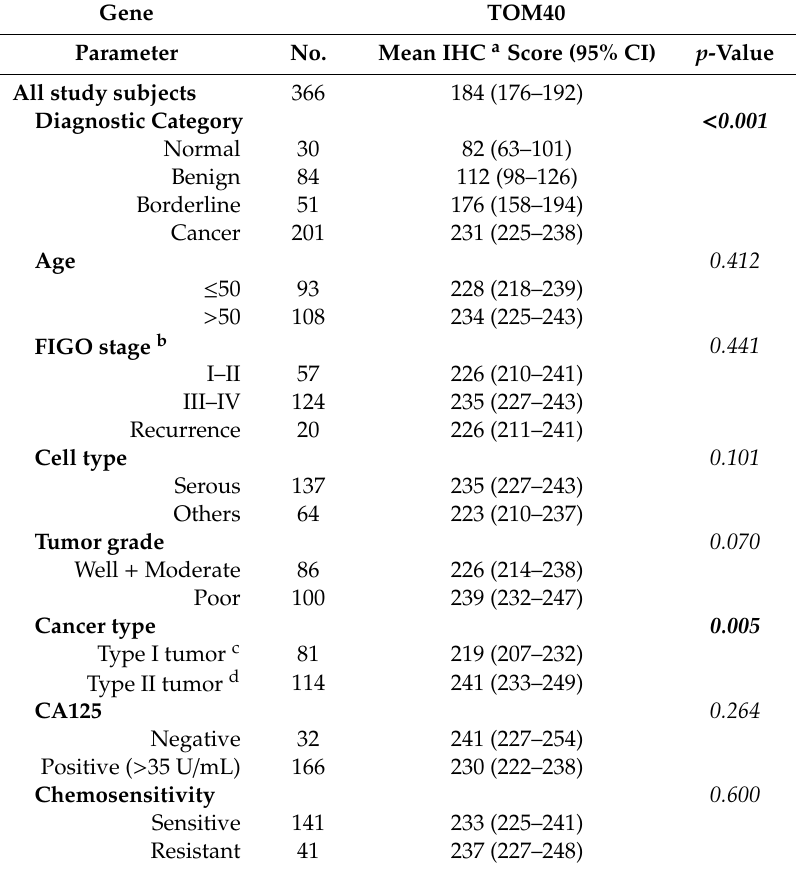
Table 1. Clinicopathologic significance of TOM40 protein expression in epithelial ovarian